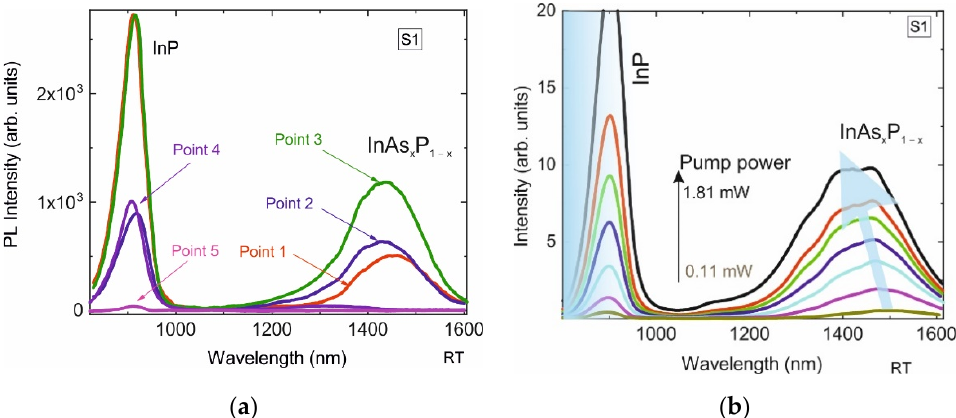
Figure 3. ( a )—PL spectra of sample S1 obtained at points 1–5 at a pump power density of 127 kW/cm 2 . ( b )—PL spectra from single InP/InAs x P 1 − x /InP nanoinsertion in sample S1 obtained at different optical pump powers (0.11 mW(14kW/cm 2 )–1.81mW(230kW/cm 2 )).